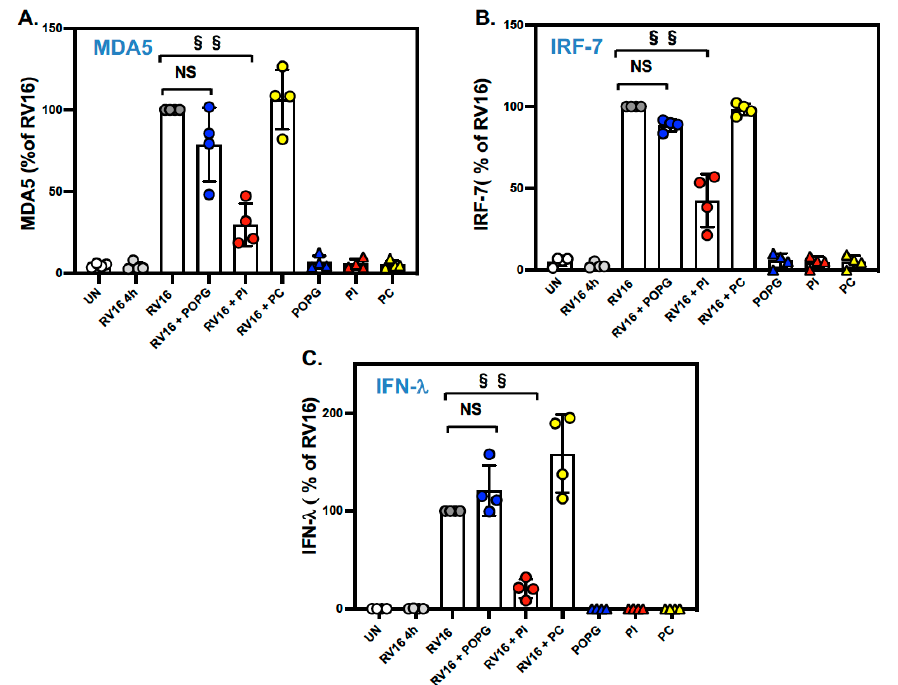
Figure 2. PI significantly reduced antiviral gene expression after the RV-A16 infection of AECs. ( A ) MDA5 mRNA expression induced by RV-A16 infection. Treatment with PI reduced MDA5 mRNA expression by 65% ( RV16 + PI as red circle) compared to RV-A16 alone ( RV16 as gray circle). ( B ) IRF-7 mRNA expression. The treatment with PI ( RV16 + PI ) reduced IRF-7 expression by 50% in comparison to RV-A16 alone ( RV16 ). ( C ) IFN-lambda expression at 48 h after RV-A16 challenge to AECs. The treatment with PI markedly attenuated IFN-lambda expression by 75% in comparison to RV16 alone. Both POPG ( RV16 + POPG as blue circle) and PC ( RV16 + PC as yellow circle) failed to impact MDA5 , IRF-7, and IFN-lambda mRNA expression in panels ( B , C ). Lipid alone treatment were shown as POPG (blue triangle), PI (red triangle) and PC (yellow triangle). The data are from 4 different healthy control donors and are shown as mean ± SD from 3 independent experiments for each individual. §§ indicates, p < 0.001, and NS indicate not significant.